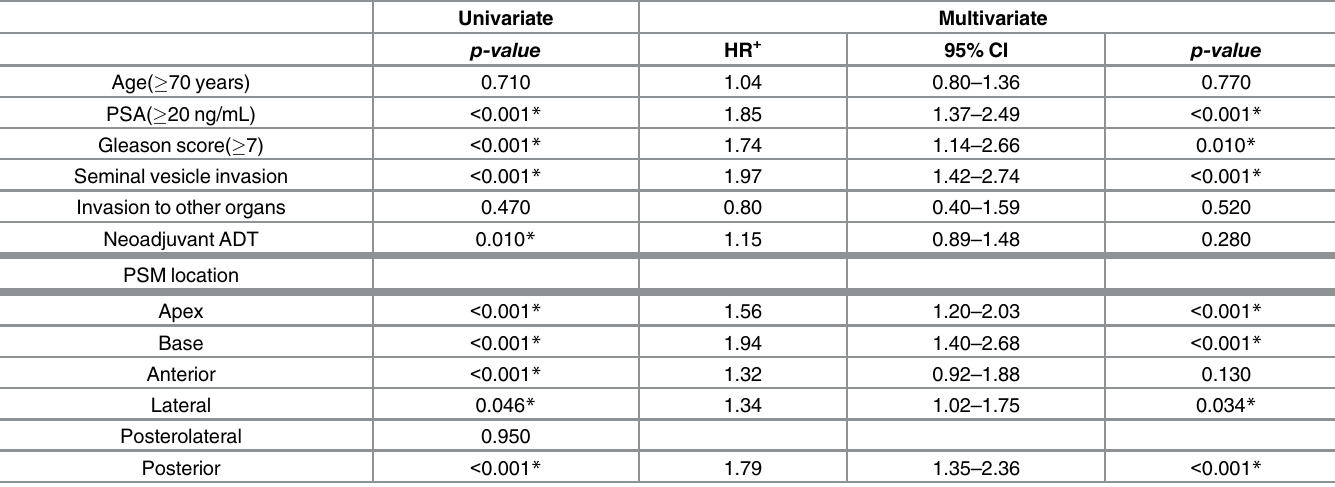
Table 2. Competing risk regression analysis for biochemical recurrence, accounting for deaths during follow-up